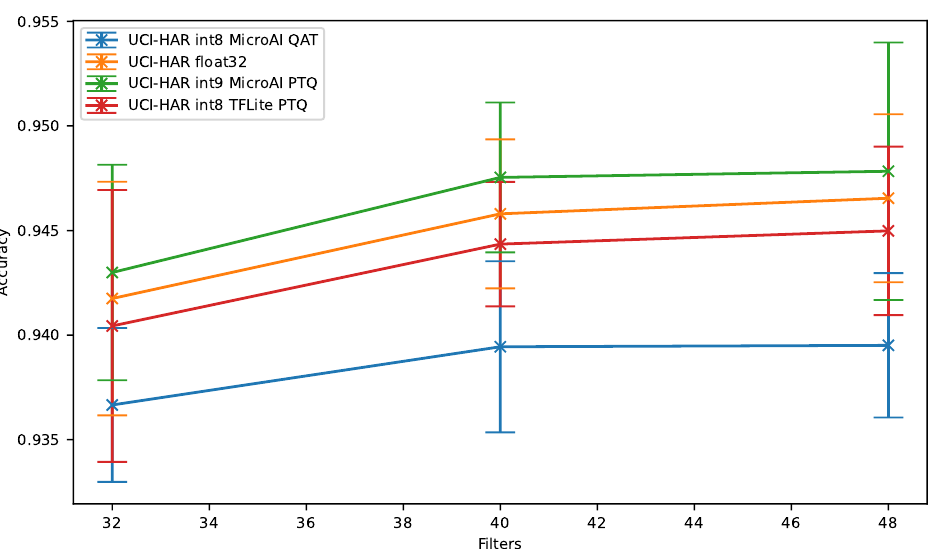
Figure A1. Accuracy vs. filters for baseline ( float32 ), 8-bit Post-Training Quantization from Tensor- Flow Lite ( int8 TFLite PTQ ), 8-bit Quantization-Aware Training from our framework ( int8 MicroAI QAT ), and 9-bit Post-Training Quantization from our framework ( int9 MicroAI PTQ ). Neural network architecture is described in Section 6 with several filters per convolution layer varying from 32 to 48 and dataset is described in Section